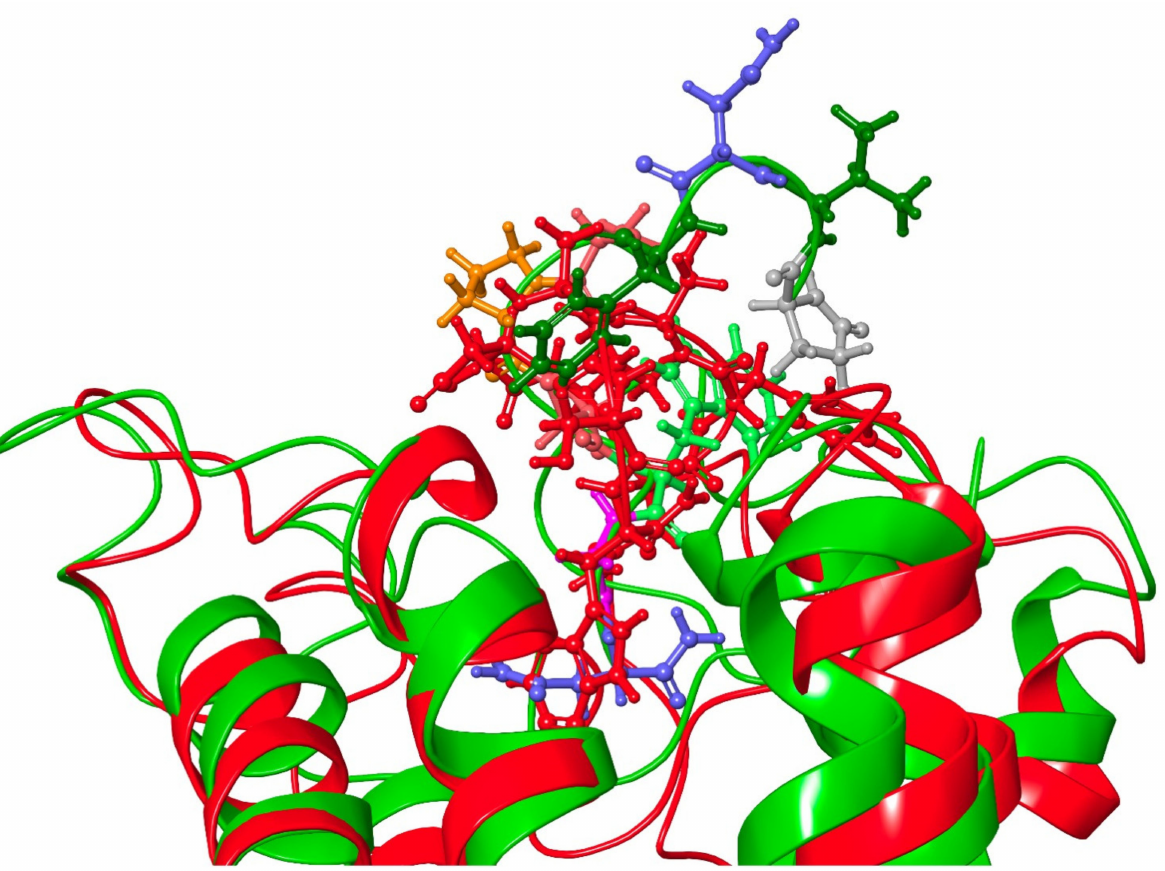
Figure 9. Overlay of Dappu-AKH + Dappu-AKH R (red) and Placa-HrTH + Dappu-AKH R (green). Note the close correspondence of the helical